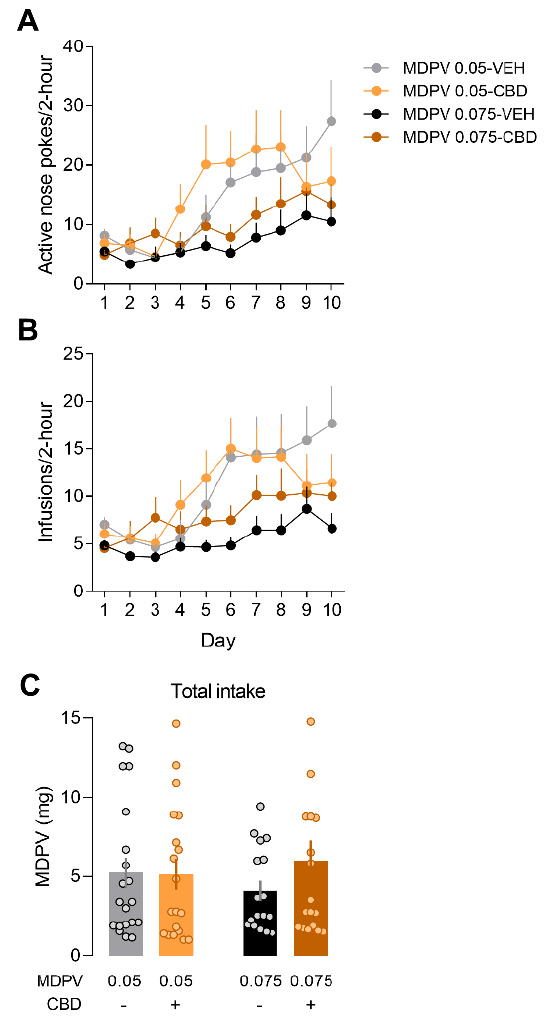
Figure 4. Mice modulate their drug-seeking behaviour to maintain MDPV consumption. ( A ) Active nose pokes and ( B ) infusions along the self-administration. ( C ) Total intake of MDPV. 3.5. CBD Increases the Anxiolytic Effects of MDPV in the EPM One-way ANOVA for the percentage of time spent in open arms (Figure 5A) revealed a significant effect of treatment (F (2,52) = 6.304, p < 0.001). Bonferroni’s post hoc analysis indicated that CBD treatment increased the percentage of time spent in open arms when administered to the MDPV 3 and 4 mg/kg mice compared to the VEH-SAL ( p < 0.05) and VEH-CBD ( p < 0.01) groups. Moreover, mice that received both MDPV 4 mg/kg and CBD displayed increased percentage of time spent in open arms compared to those that only received MDPV 4 mg/kg ( p < 0.05). In addition, the one-way ANOVA for the number of entries in open arms revealed a significant effect of treatment (Figure 5B; F (2,51) = 5.04, p < 0.001). The post hoc analysis indicated that the number of entries in open arms was increased in the CBD-MDPV 3 mg/kg ( p < 0.05), VEH-MDPV 4 mg/kg ( p < 0.05) and CBD-MDPV 4 mg/kg ( p < 0.01) groups compared to the VEH-SAL group. Moreover, the number of entries in open arms was also increased in the CBD-MDPV 4 mg/kg group compared to the CBD-SAL group. Finally, the one-way ANOVA for total distance revealed a significant effect of treatment (Figure 5C; F (5,50) = 4.65, p < 0.01). The post hoc analysis of MDPV dose indicated that mice treated with MDPV 3 mg/kg and vehicle traversed more distance compared to the VEH-SAL group ( p <